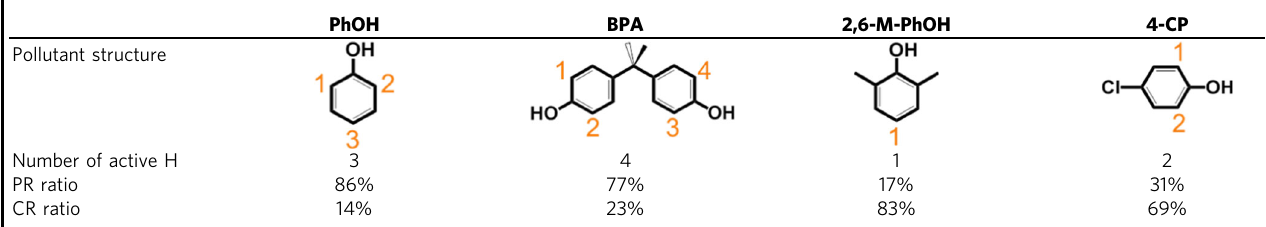
Table 1 Quantitative structure – activity relationship (QSAR) of pollutants between the number of active hydrogen atoms and the corresponding percentages of coupling reaction (CR) and polymerization reaction (PR) pathways in